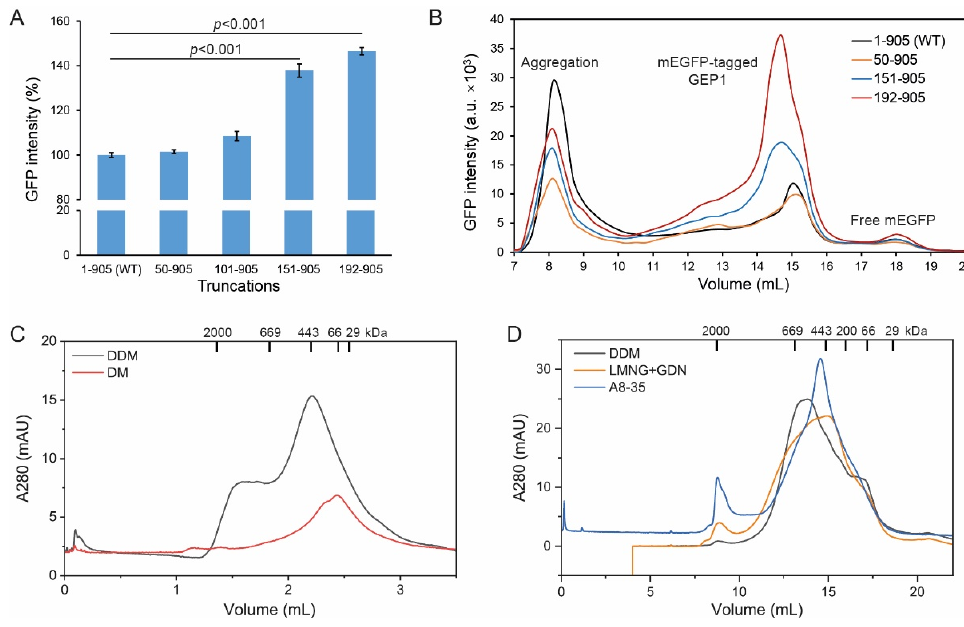
Figure 3. N-terminal truncation and trapping in A8-35 increased the expression level and stability of GEP1. ( A ) Expression level of N-terminal truncation on GEP1 with mEGFP tag; data were ana- lyzed using a two-tailed unpaired Student’s t-test. ( B ) Fluorescence-detection size-exclusion chro- matography (FSEC) traces of crude detergent extract of GEP1 truncations with mEGFP tag. ( C ) Size exclusion chromatography (SEC) profiles of GEP1 151-905 in detergent DDM and DM. The dispersity was determined on a Superose 6 Increase 5/150 GL column. ( D ) SEC profiles of GEP1 151-905 solubil- ized in detergents or trapped in amphipol A8-35. The dispersity was determined on a Superose 6 Increase 10/300 GL column.